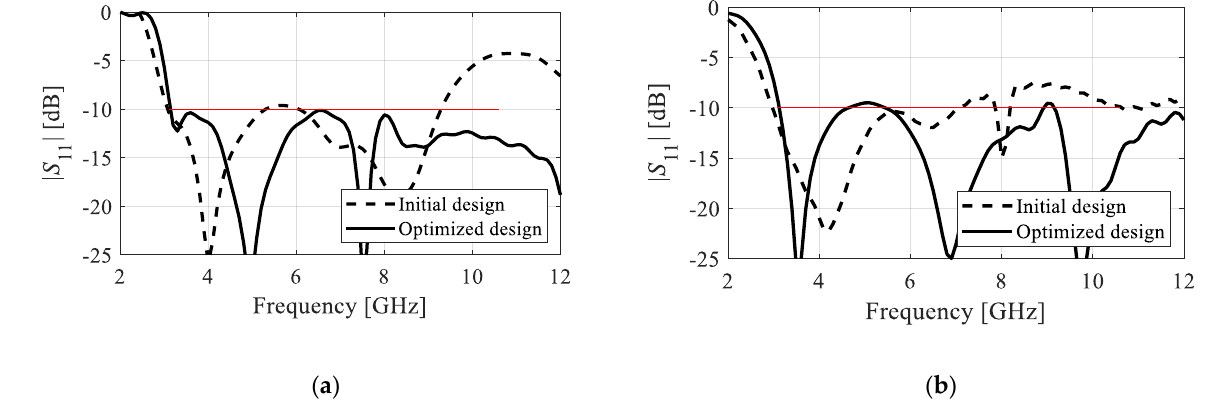
Figure 7. Reflection responses for the representative runs of the proposed multi-fidelity algorithm for simulation-driven size reduction: ( a ) Antenna I, ( b ) Antenna II. The initial and optimized designs are marked using the dashed and solid lines, respectively. The horizontal lines mark the design specifications. Note that the maximum reflection at the optimized design is around the level of −10 dB which indic ates that the reflection constraint is active.